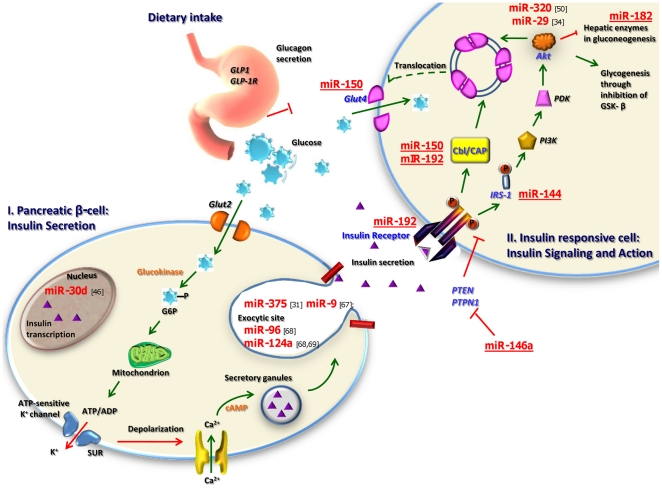
Possible mode of mechanism on miRNA-regulatory networks.Possible ways in which miRNA govern different stages of the insulin pathway in the pathogenesis of Type 2 Diabetes. miRNAs that have been reported in previous studies are indicated in brackets while those underlined are predicted by the five best target prediction databases namely RegRNA, MirBase, TargetScan, Mirgen and microRNA.org.